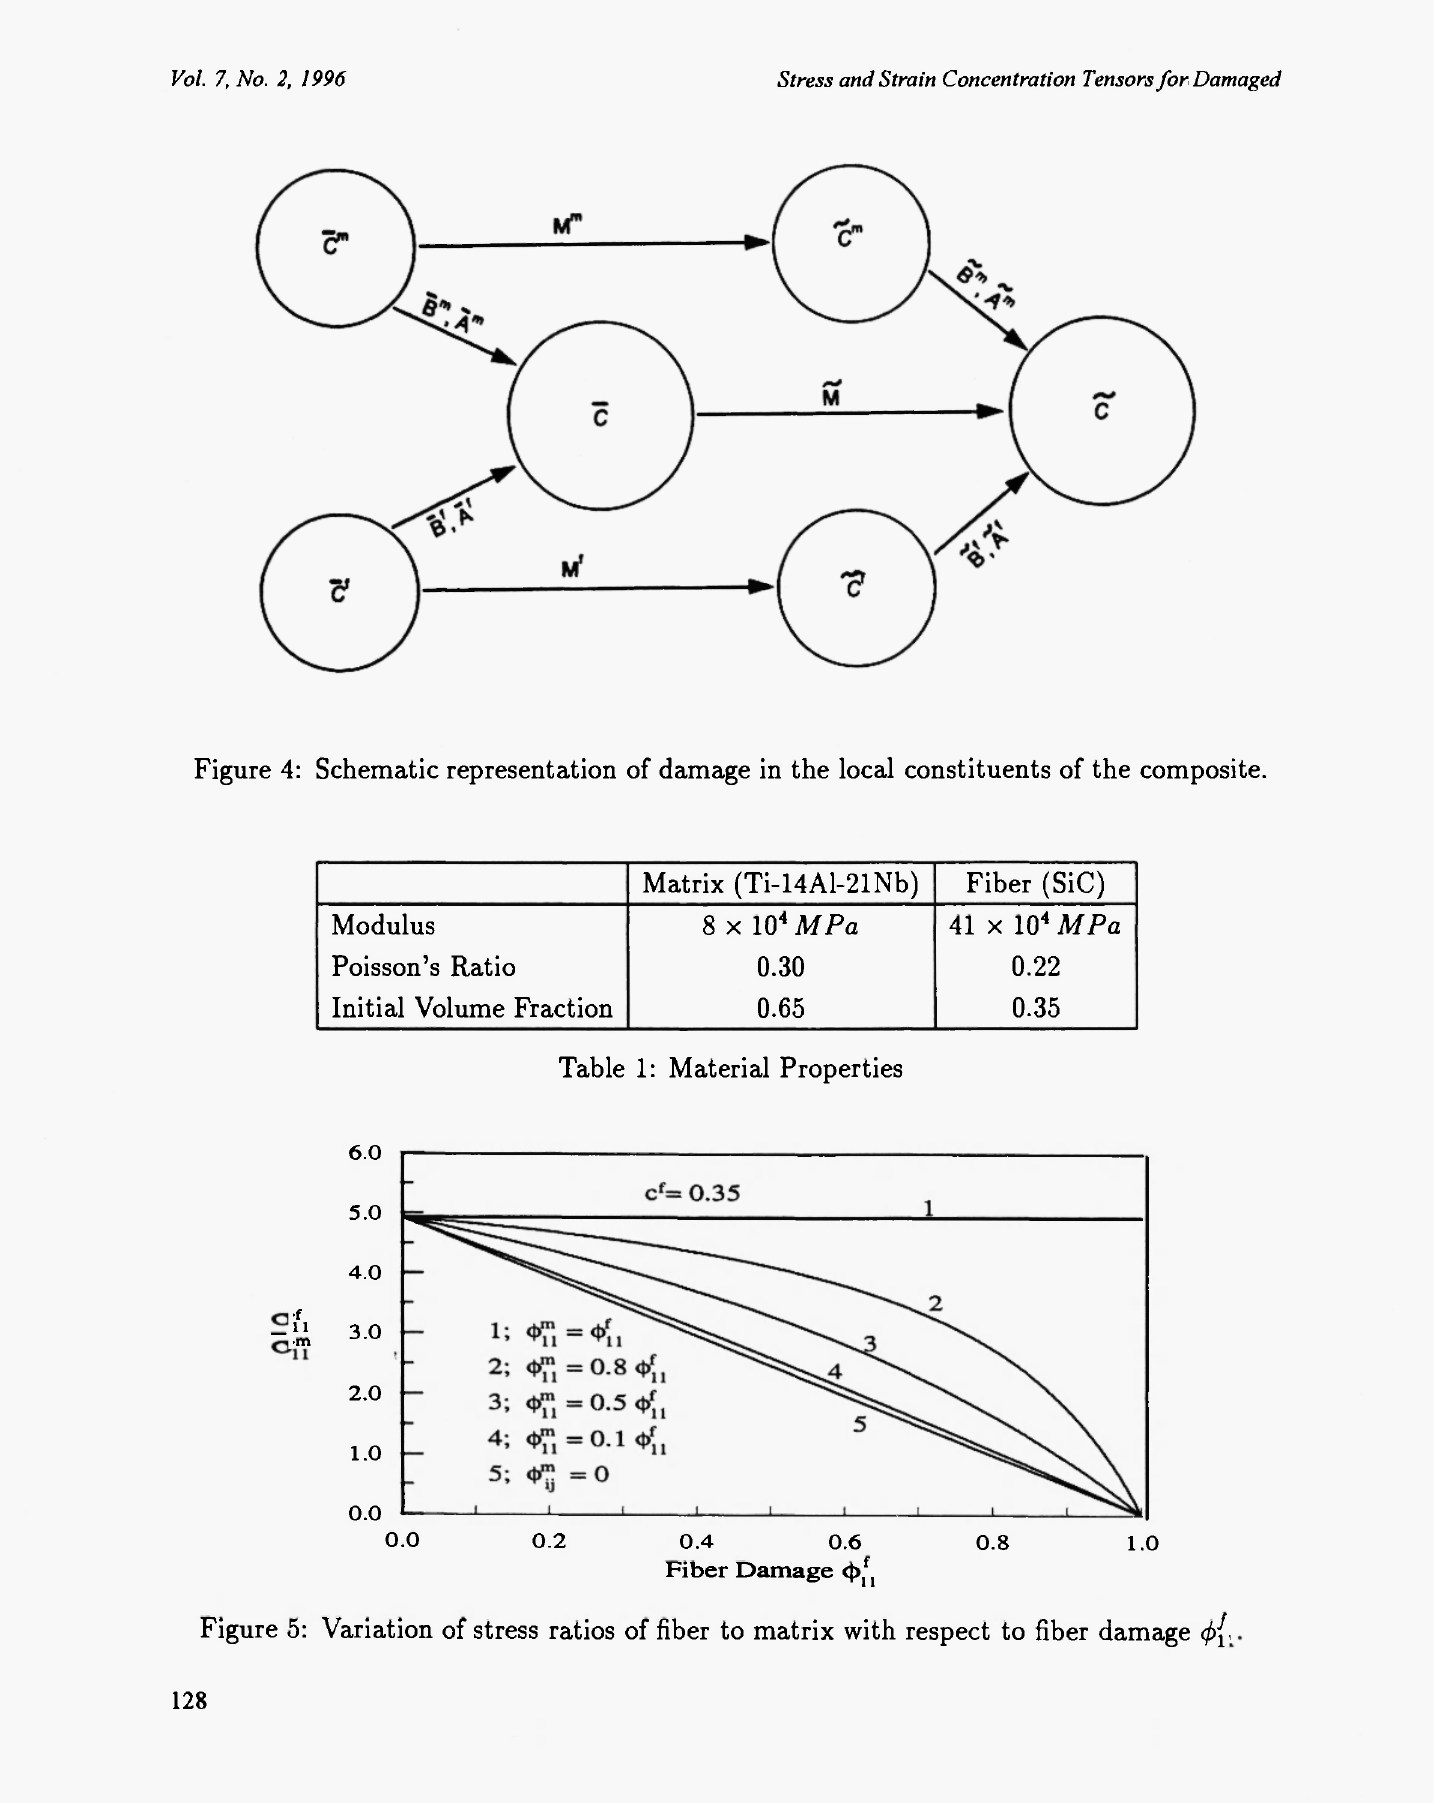
Figure 5: Variation of stress ratios of fiber to matrix with respect to fiber damage